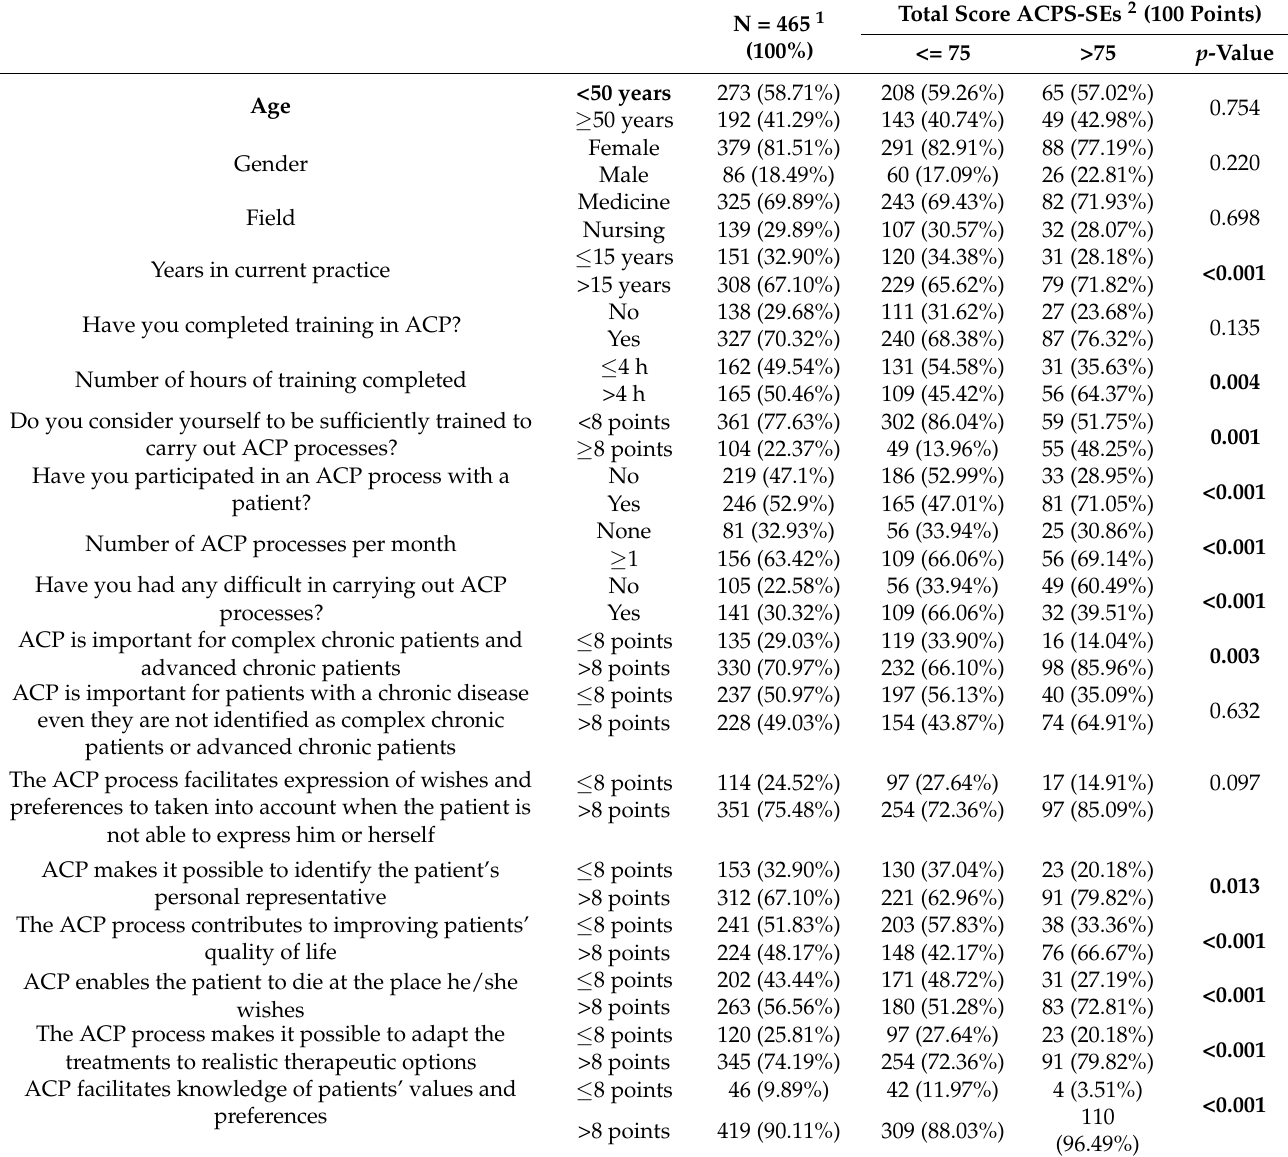
Table 5. Comparison of the total ACP score categorized according to Q3 cut-off of 75 points on the APC-SEs scale and sample characteristics and variables of interest in the questionnaire. Bivariate